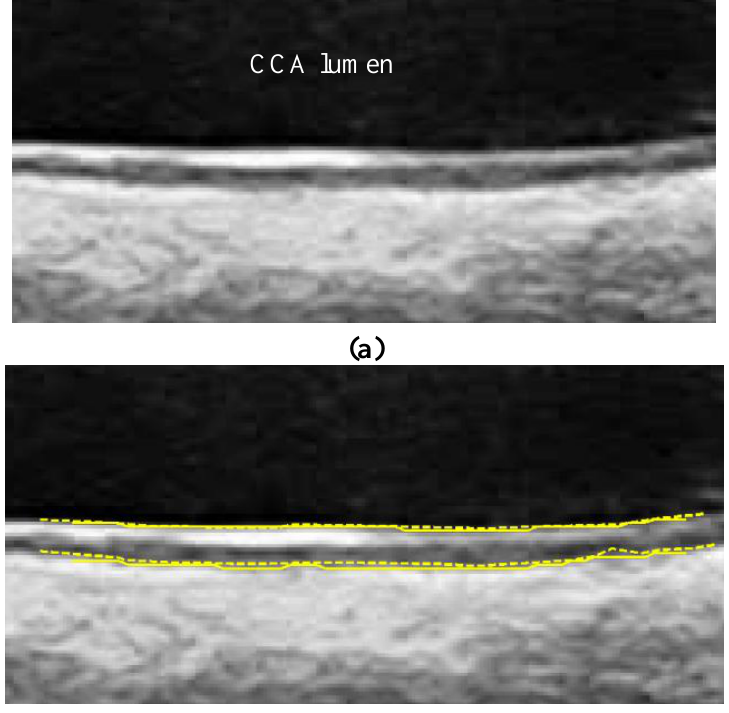
Figure 8. Far wall IMT detection. (a) Raw sub-image. (b) Solid line: Automatic detection result. Dash line: Manual drawing. (Sequence